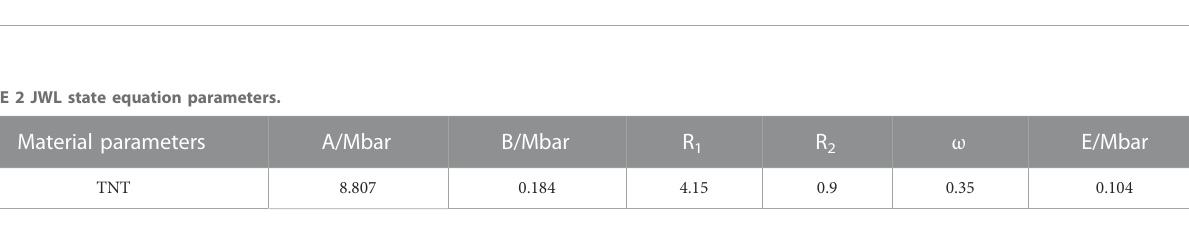
FIGURE 4 Comparison between measured results and numerical results. (A) Measured and numerical simulation shock wave pressure peak. (B) Measured and numerical simulation shock wave pressure peak error.